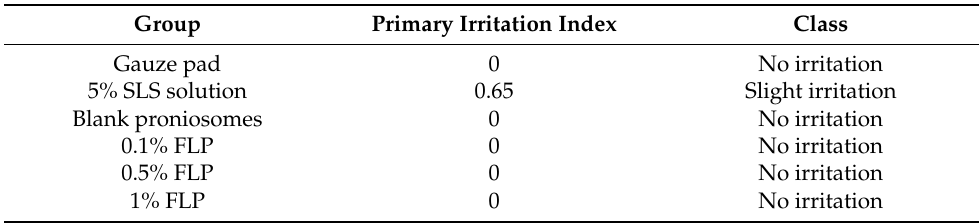
Table 8. Skin primary irritation index. FLP, Finasteride